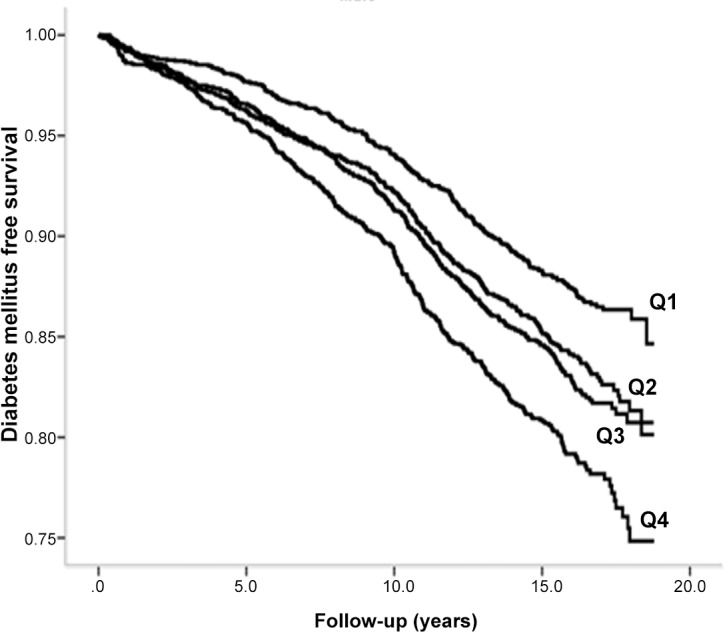
Diabetes mellitus free survival in relation to quartiles of total leukocytes in men.